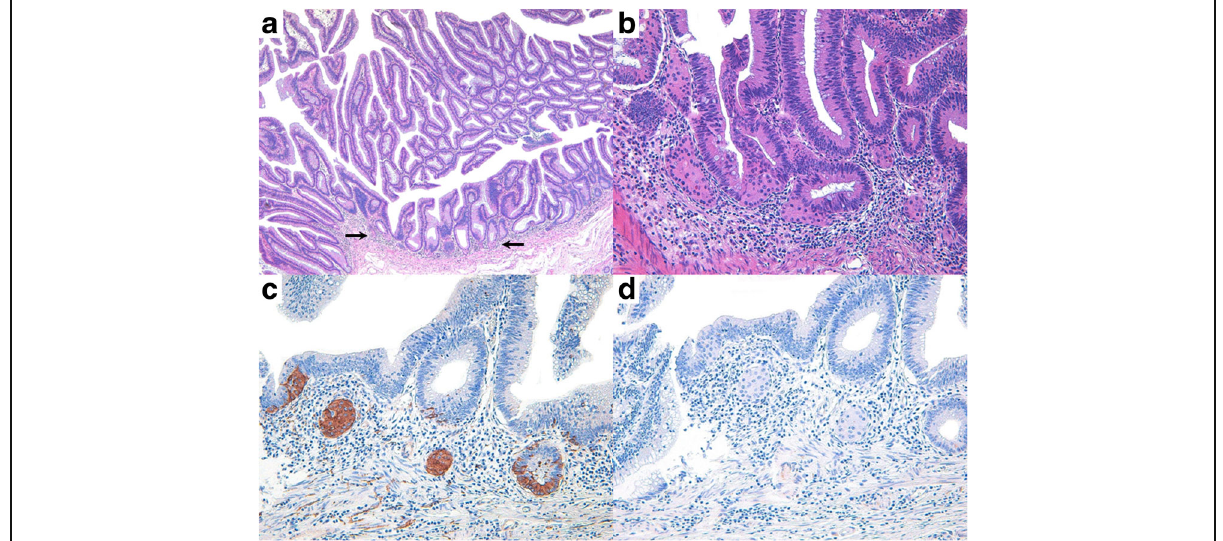
Fig. 3 Histological and immunohistochemical features of composite intestinal adenoma-microcarcinoid, mimicking adenoma with squamous metaplasia (squamous morules). a Low power magnification shows adenomatous glands with a few eosinophilic cell nests (black arrows) in basal lamina propria (×40). b High power magnification shows adenomatous glands and eosinophilic cell nests resembling squamous metaplasia (×200). c Immunohistochemical staining for synaptophysin shows diffuse cytoplasmic reactivity in the eosinophilic cells nests, supporting the neuroendocrine differentiation (×200). d The neuroendocrine component is negative for chromogranin-A on immunostaining